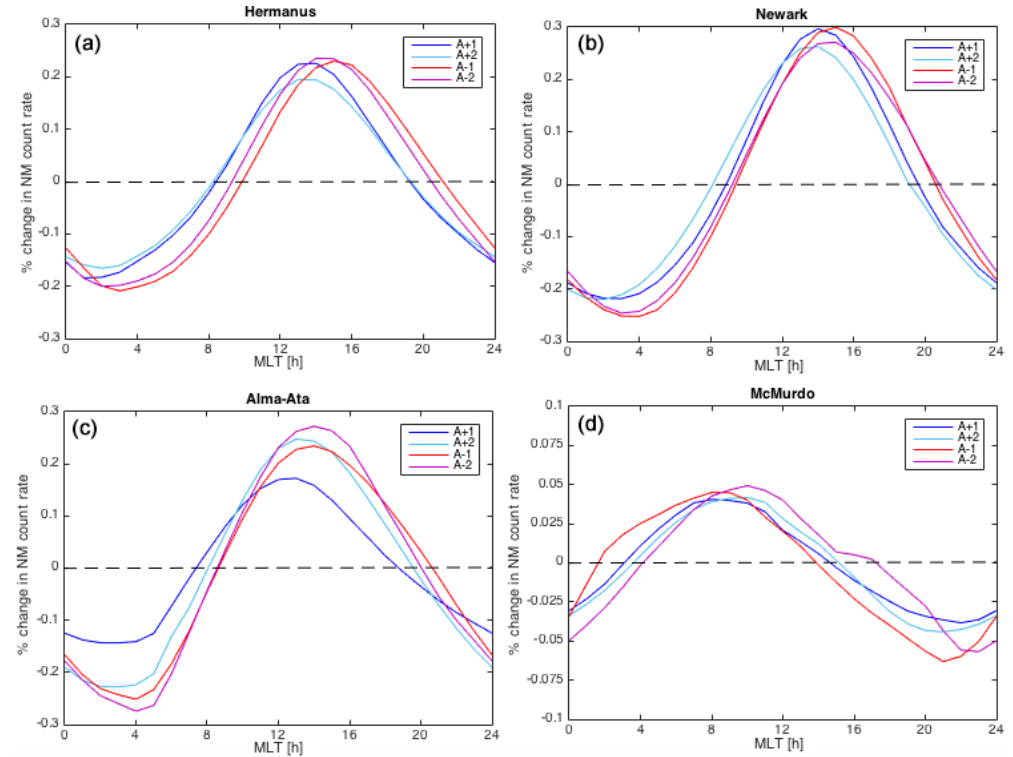
Figure 2. Mean diurnal variations of neutron monitor count rates from Hermanus, South Africa (a) , Newark, USA (b) , Alma-Ata, Kazakhstan (c) , and McMurdo, Antarctica (d) . The data are split into four consecutive polarity cycles (see Thomas et al., 2014a), where A< 0 cycles are shown in red/pink, denoted A − 1 and A − 2, and A> 0 cycles are shown in blue/light blue, denoted A + 1 and A +